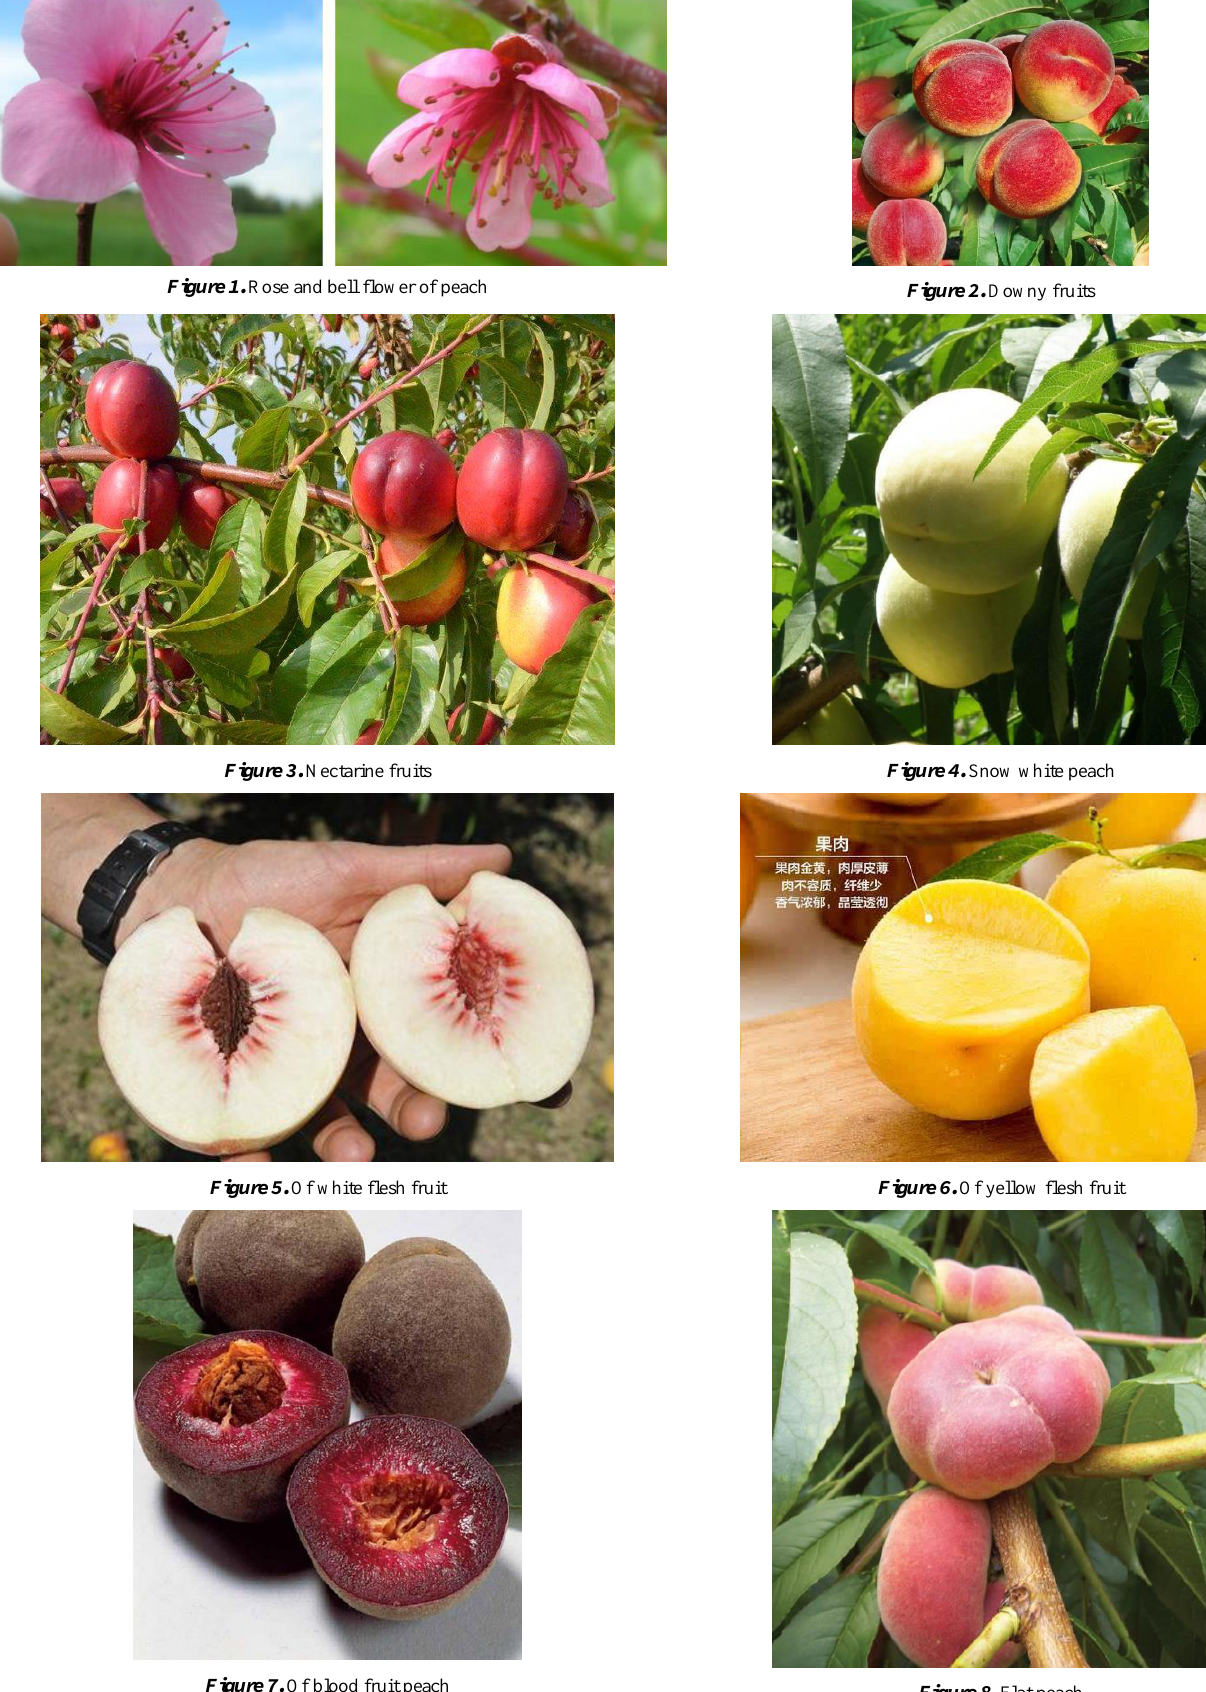
Figure 7. Of blood fruit peach Figure 8. Flat